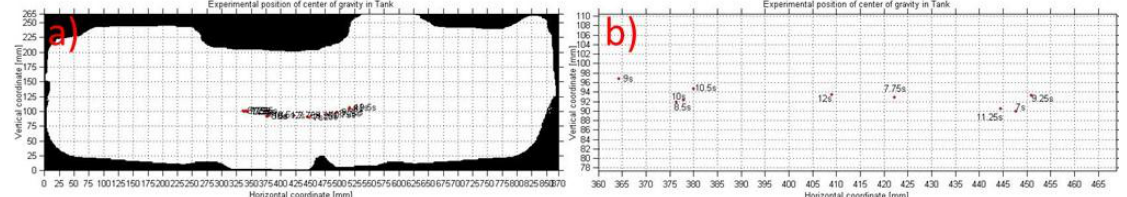
Figure 4. Experimental center of gravity position during the test, ( a ) Time interval [7 ÷ 12] s, ( b ) Zoom around the center of gravity of the